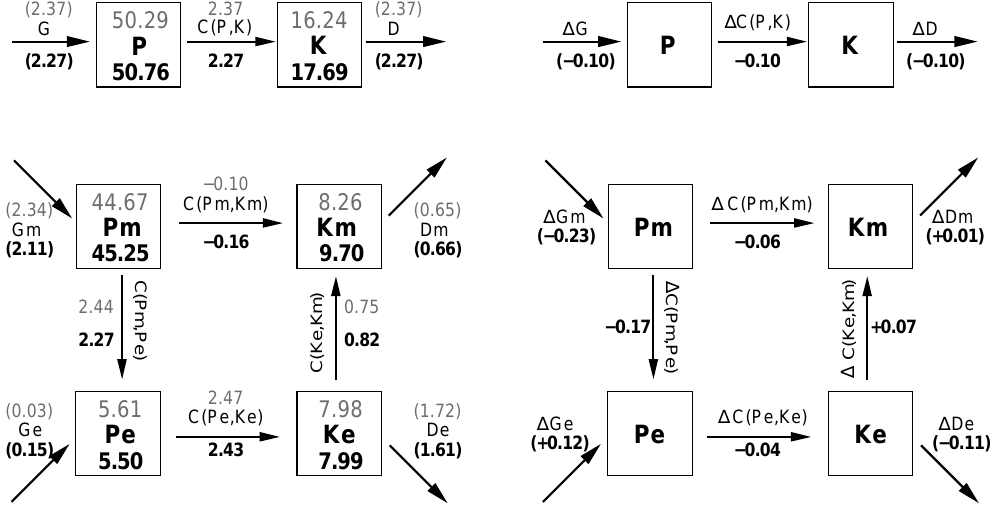
Fig. 1. 2-box (above) and 4-box (below) diagrams of the LEC. Left panel shows values for the 1 × CO 2 control run (above, gray) and the 2 × CO 2 equilibrium run (below, black). Generation and dissipation terms (in parenthesis) are obtained as residuals. Right panel shows the changes in energy generation, conversion and dissipation rates when doubling CO 2 concentrations. Units are 10 5 Jm − 2 for reservoirs and Wm − 2 for conversion, generation and dissipation terms. Arrows indicate the direction corresponding to positive values; negative values imply opposite